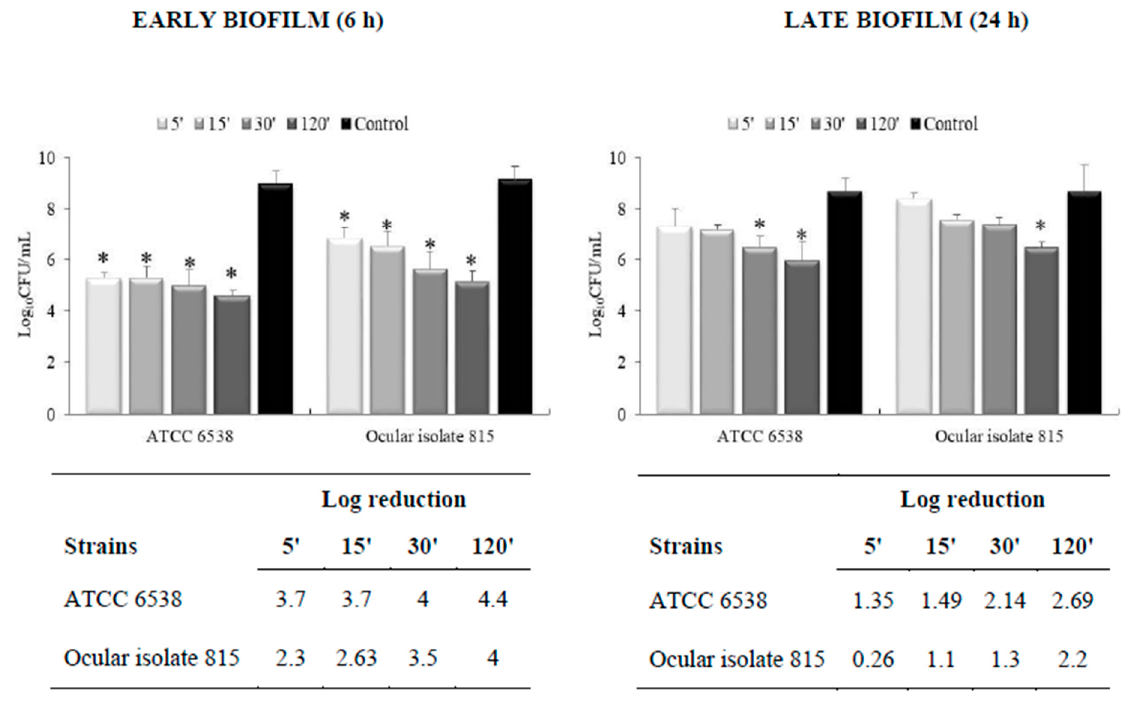
Figure 1. Quantitative measurement of S. aureus biofilm-embedded cells after treatment with CST. Data are expressed as means ±SD of three independent experiments carried out in triplicate and relative Log reduction. *, p -value < 0.05 shows the statistical difference between treated groups and control groups.